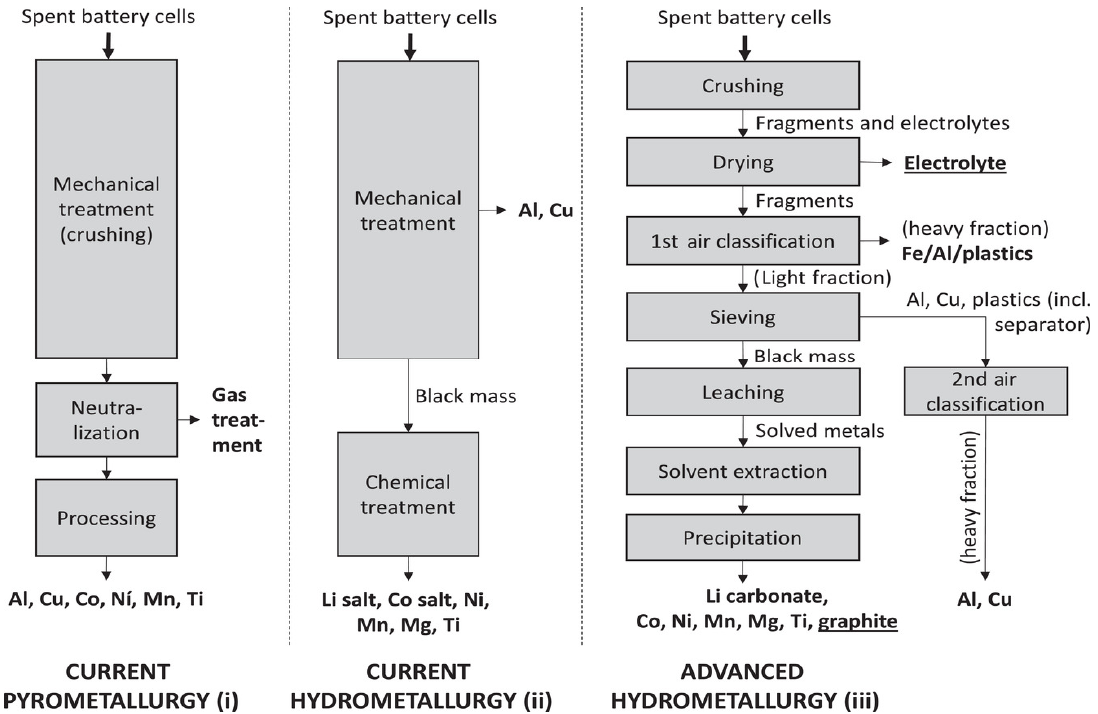
Figure 6. Process flows, including all considered product outputs. Reprinted from Journal of Industrial Ecology, Vol. 24, Mohr et al. [161], Toward a cell-chemistry specific life cycle assessment of lithium-ion battery recycling processes, no. 6, pp. 1310–1322, Copyright (2022), distributed under Creative Commons Attribution License.